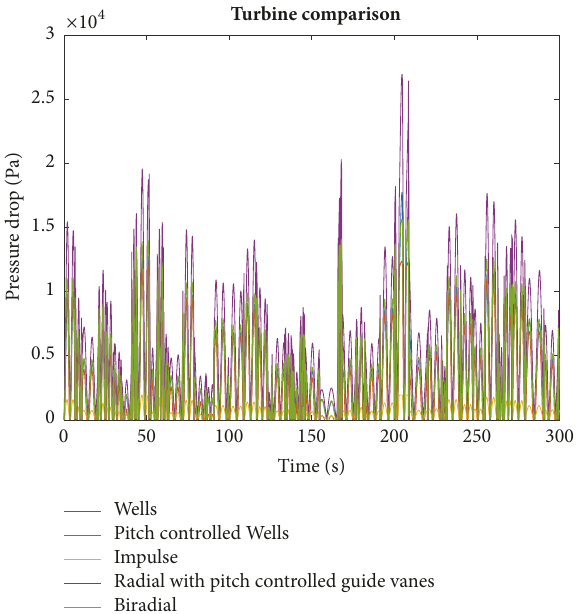
Figure 11: Model pressure drop output for the different turbines.